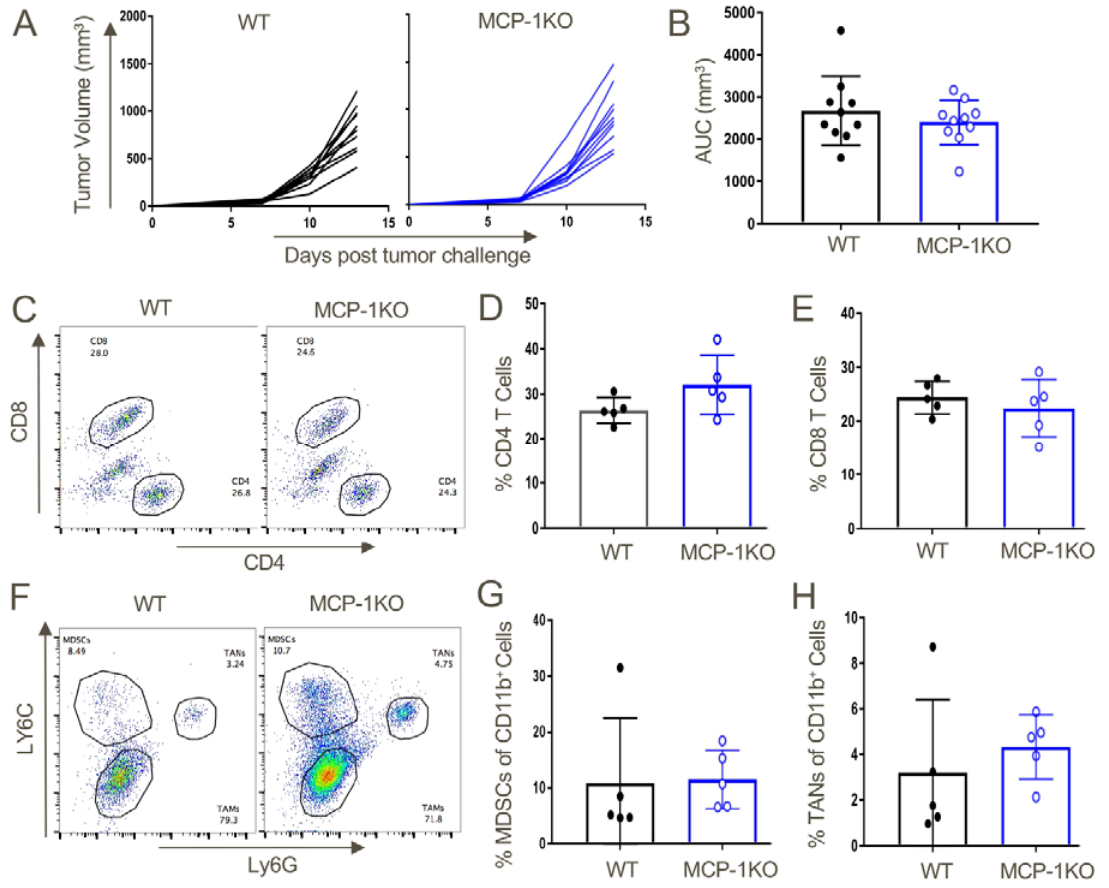
Figure 13. Tumor-derived MCP-1 appears indispensable for the growth of TC1 tumors and recruitment of MDSCs to the tumor microenvironment. TC1 tumors were transplanted in WT or MCP-1KO mice and monitored until day 13 post-injection, when they were harvested and analyzed by flow cytometry. ( A ) Tumor growth curves in WT and MCP-1KO mice and ( B ) area under the curve analysis. Intratumoral T cell analysis from WT and MCP-1KO mice revealed comparable ( C , D ) CD4 and CD8 ( C , E ) T cell populations. Myeloid lineage analysis also displayed similar overall frequencies of ( F , G ) MDSCs and ( F , H ) TANs in tumors grown in WT vs. MCP-1KO mice ( n = 5 / group and data are representative of three independent experiments).